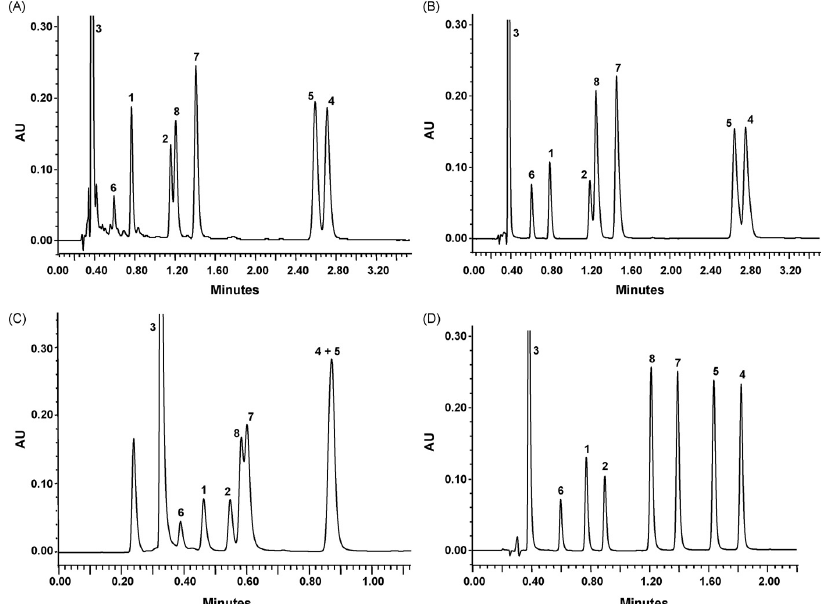
Figure 5. Optimal UHPLC chromatograms of an eight standard polyphenols mixture at 20 g/mL. ( A ) Acquity BEH C18 50 × 2.1 mm ID, 1.7 μm column. ( B ) Hypersil GOLD C18 50 × 2.1 mm ID, 1.9 μm column. ( C ) Acquity BEH phenyl 50 × 2.1 mm ID, 1.7 μm column. ( D ) Acquity BEH Shield RP18 50 × 2.1 mm ID, 1.7 μm column. 1: C, 2: EC, 3: GA, 4: CG, 5: ECG, 6: EGC, 7: GCG, 8: EGCG. Reprinted with permission from ref. [78] . Copyright 2010 Elsevier.